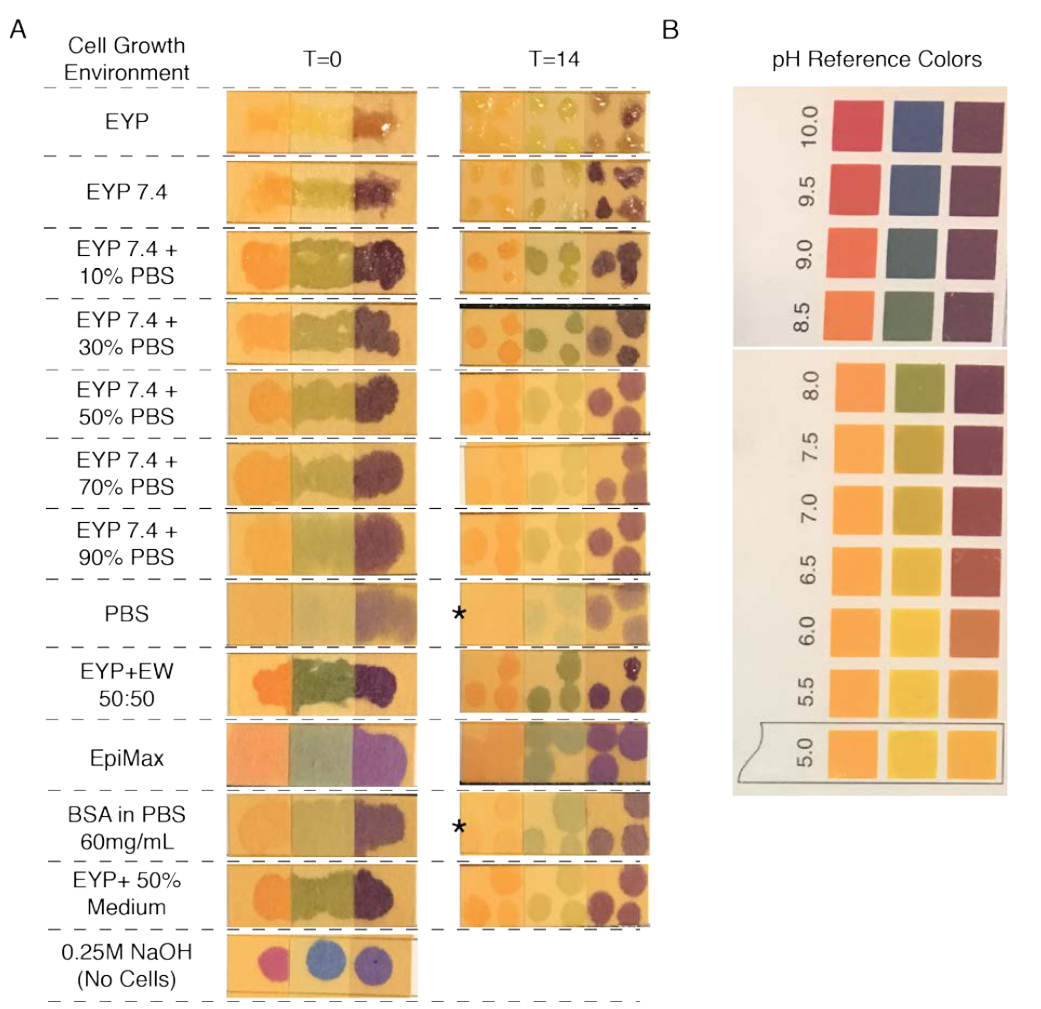
Figure A6. Cropped Pictures of pH Paper Strips Infused With μL of Cell Growth Environment Before and After 14 Days of Culture. Some samples were left to air dry longer (5–20 min) than others before a picture was taken affecting the intensity of the colour; therefore, the intensity is not as important as the colour. ( A ) Most cell growth conditions tested. The asterisk is indicative of samples taken at 7 days instead of 14. NaOH without cells serves as positive control for the pH paper’s effectiveness. ( B ) A cropped pictured from the pH paper’s box showing reference colours.